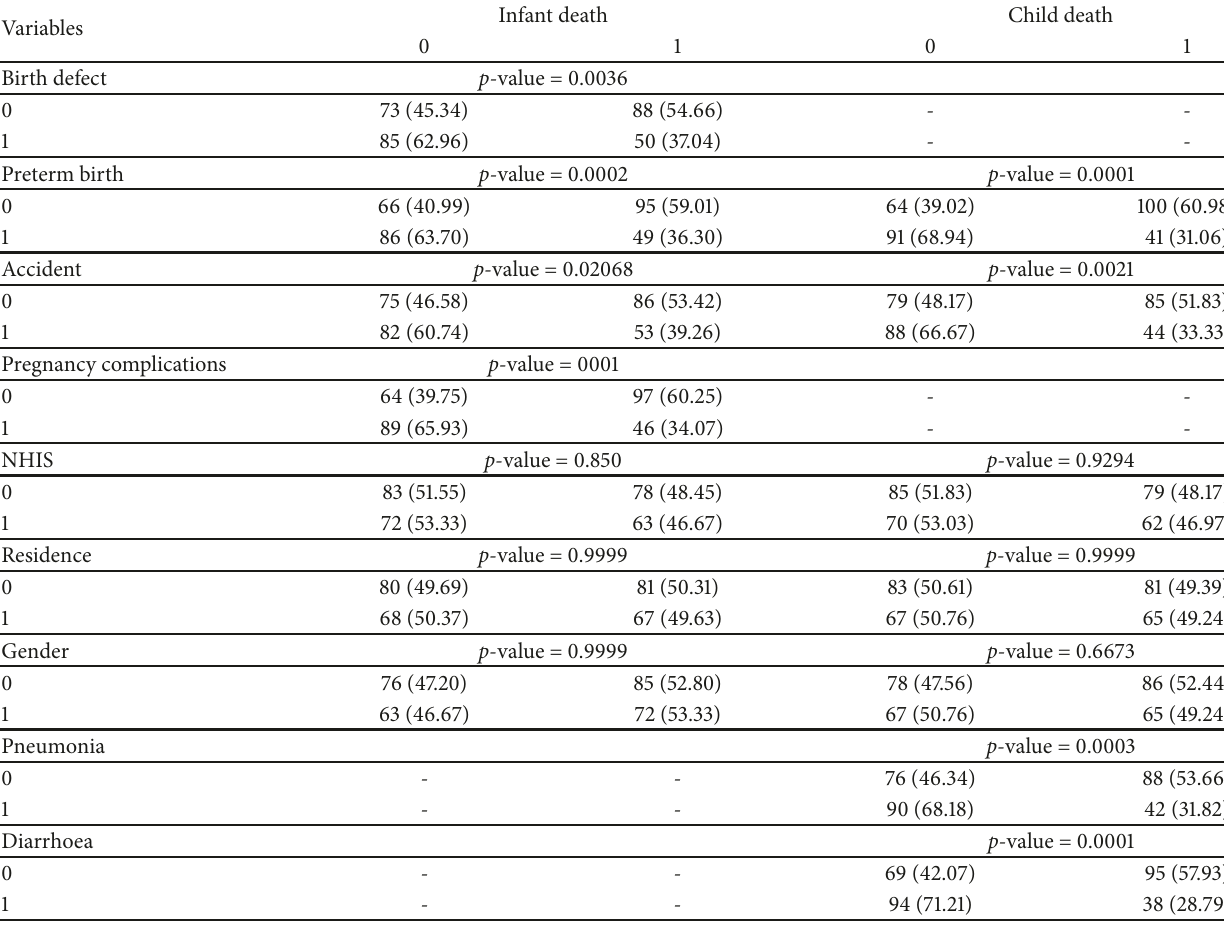
Table 1: A Chi-Square test of association between dichotomous variable (death or no death) and explanatory variables. Variables